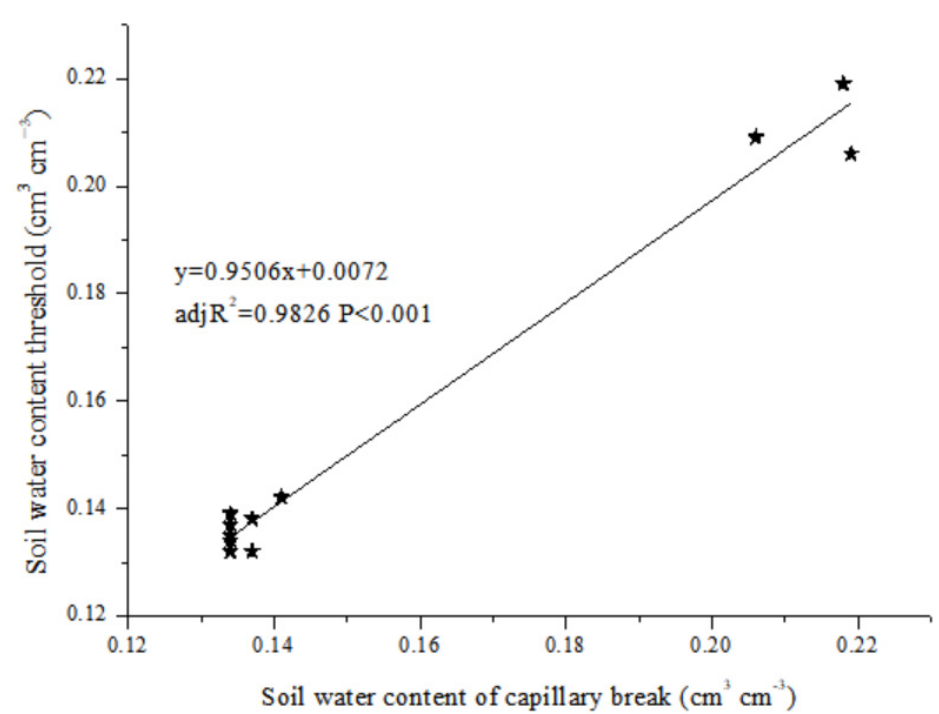
Figure 1. Relationship between soil water content threshold ( θ THR ) and soil water content of capillary break ( θ CB ) of six soils.